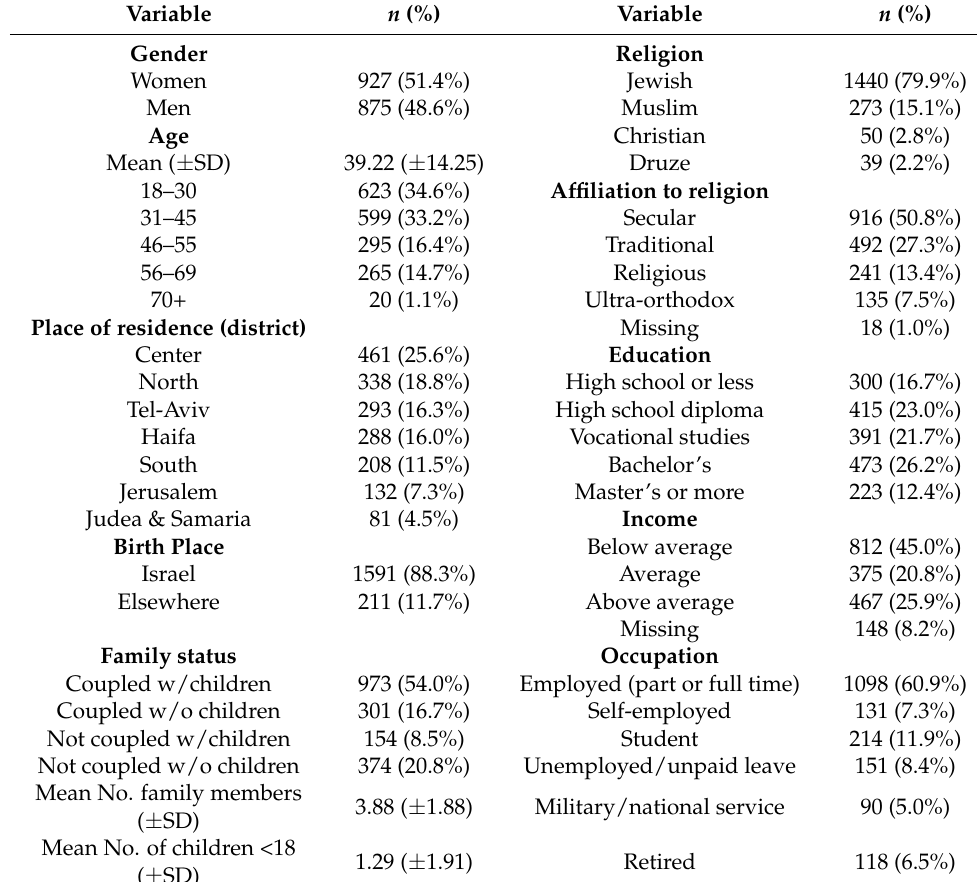
Table 1. Socio-demographic breakdown of study sample + ( N = 1802). Variable n